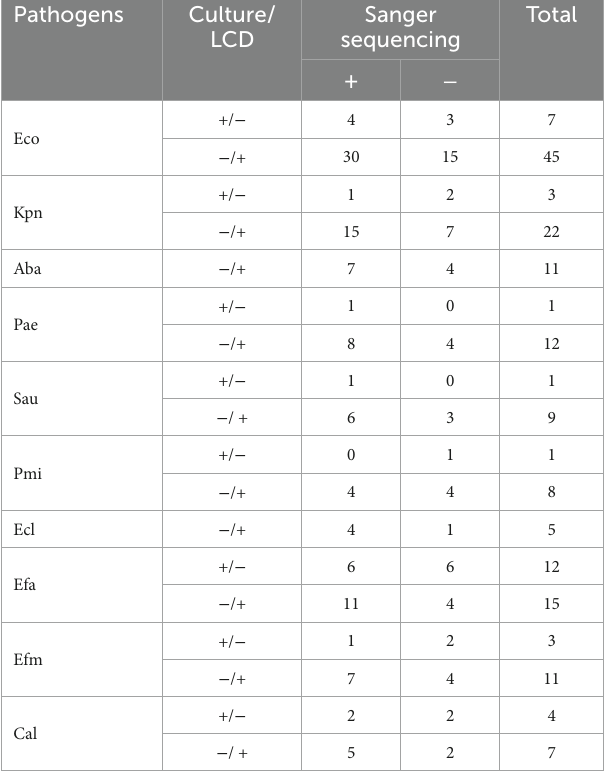
TABLE 2 Sanger sequence analysis of 177 inconsistent results between the LCD and culture for pathogens.